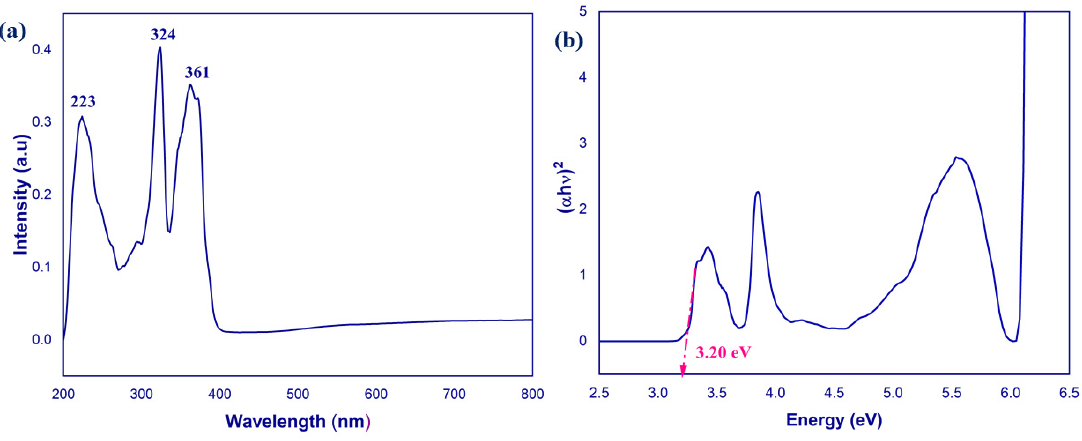
Figure 7. ( a ) Room temperature UV–vis absorption spectrum. ( b ) Tauc plot of (C 2 H 7 N 4 O) 2 BiCl 5 . The bands centered at around 324 and 364 nm were generated by the metal-centered (MC) transition and ligand-to-metal charge transfer (LMCT)